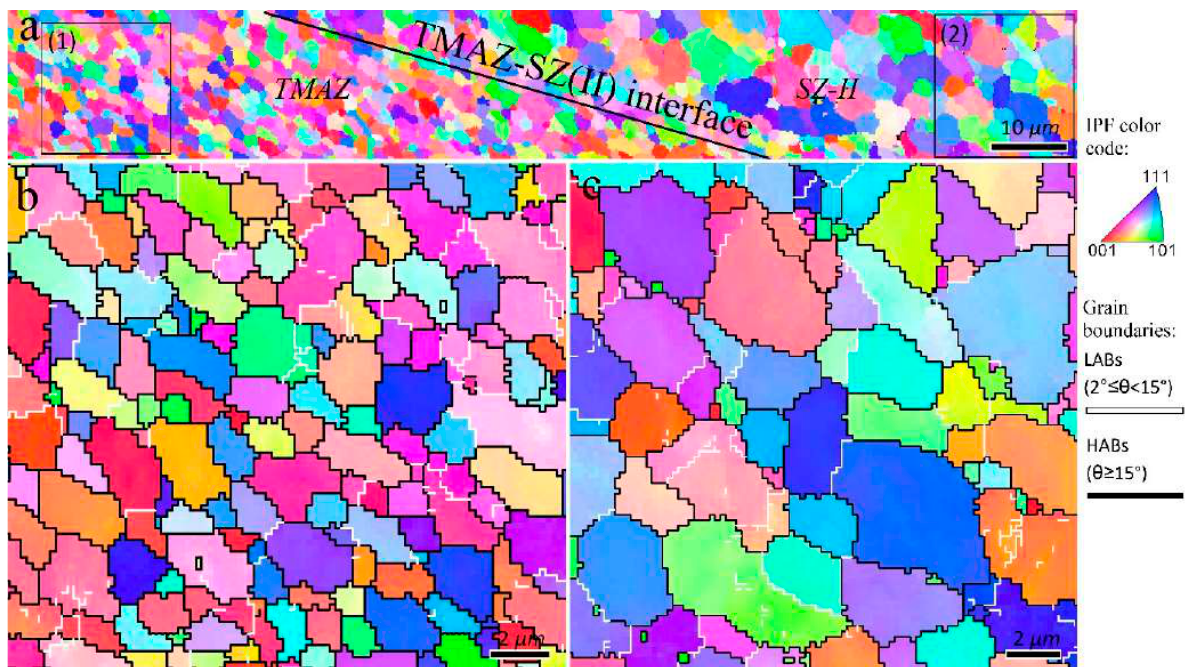
Figure 5. ( a ) Inverse pole figure maps of the interfacial zone between TMAZ and SZ-II regions in 1-pass sample indicated by rectangle 3 in Figure 2b. ( b , c ) Higher magnification of zones 1 and 2 indicated in ( a ), respectively.